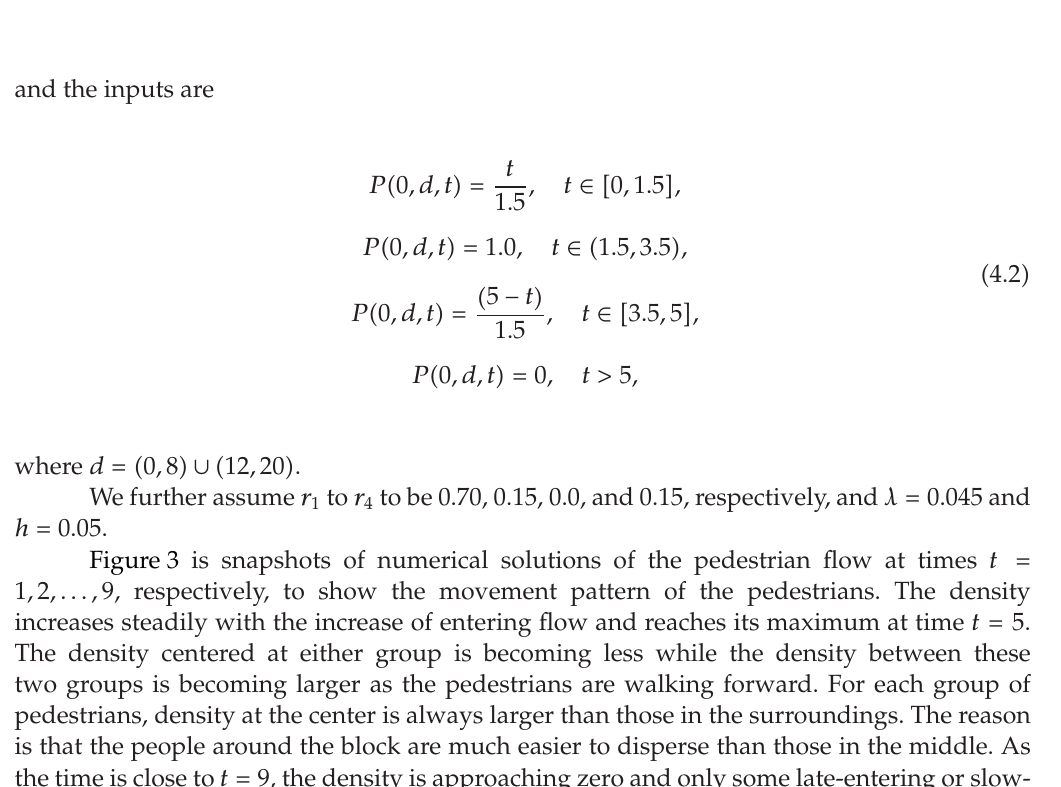
Figure 2: Schematic illustration of the one-way pedestrian flow in a platform. The length of the platform is 30 and the width is 20. The left dashed lines represent two entrances and the right one is exit. Solid lines are